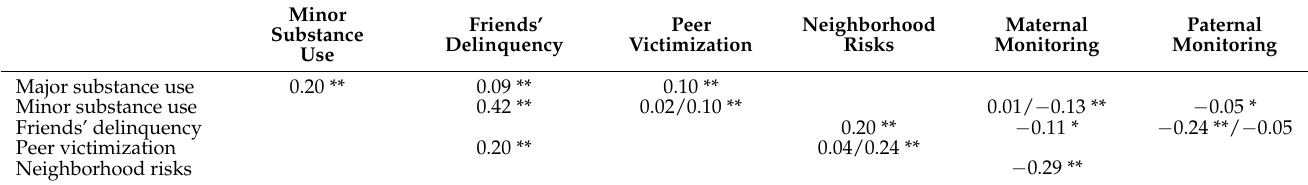
Table 4. Significant path coefficients (unstandardized) for boys/girls.